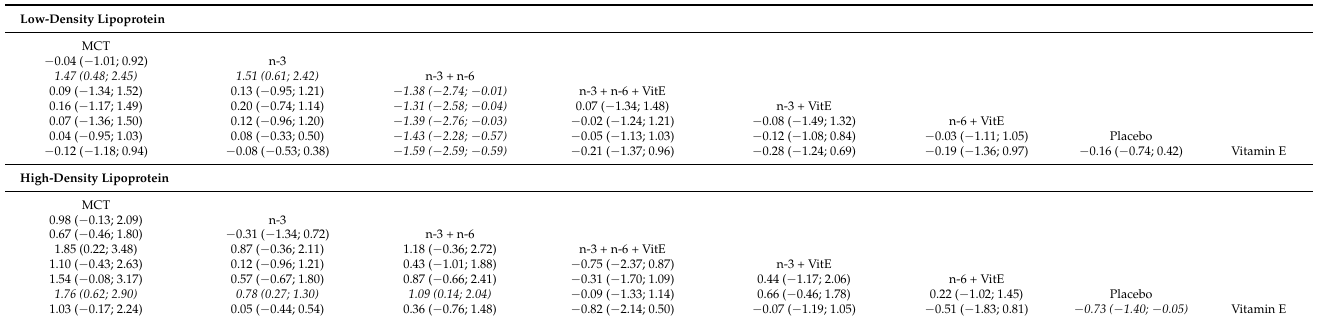
Table 2. League table of low-density lipoprotein and high-density lipoprotein (standardized mean difference with 95% confidence interval).